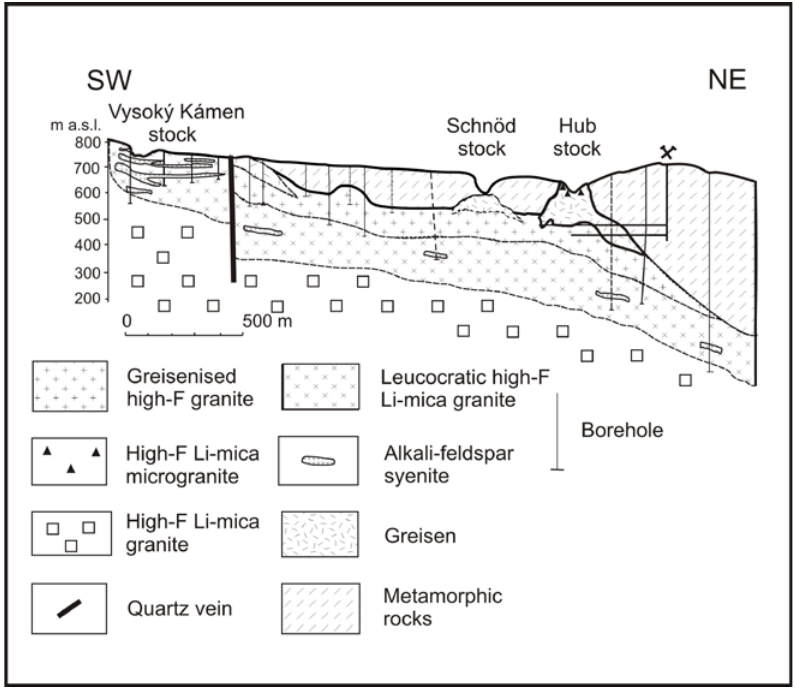
Figure 2. Geological cross section of the Horní Slavkov - Krásno ore district, modified after [19].